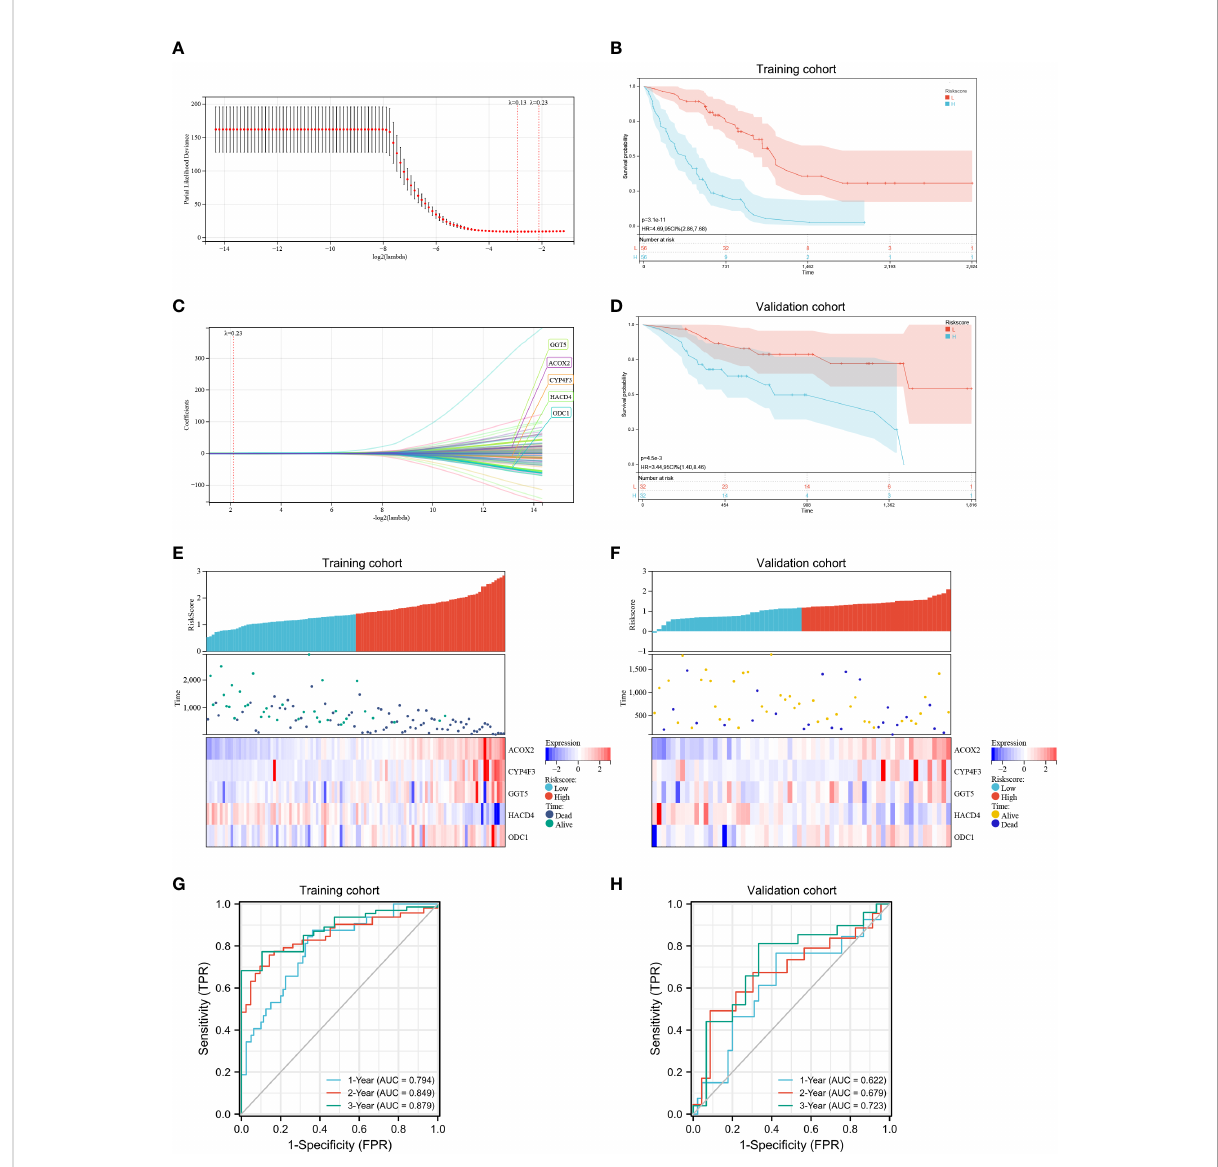
FIGURE 5 Development and assessment of a prognostic fatty acid metabolism-related signature for patients with IPF. (A, B) LASSO regression analysis with optimal lambda. (C, D) Kaplan – Meier survival analysis of patients with high- and low- Riskscore in training (C) and validation cohorts (D) , IPF patients in the high- Riskscore group had poor survival prognosis compared to patients in the low- Riskscore group. (E, F) Distribution of the Riskscore, survival status, and the expression of the fi ve candidate genes in the high- and low- Riskscore groups in the training (E) and validation (F) cohorts. (G, H) In the training (G) and validation (H) cohorts, time-dependent receiver operating characteristic analysis showed that the Riskscore had better performance in predicting the survival of patients with